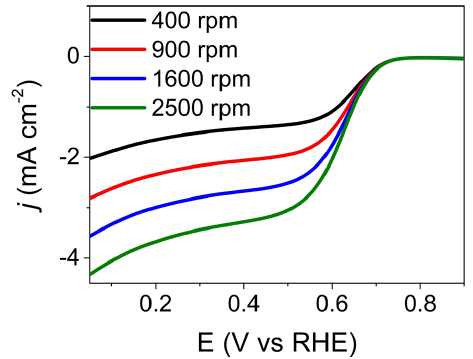
Figure 4. ORR curves of the electrocatalysts and of Pt/C 20 wt.% (Pt loading of 25.46 µg